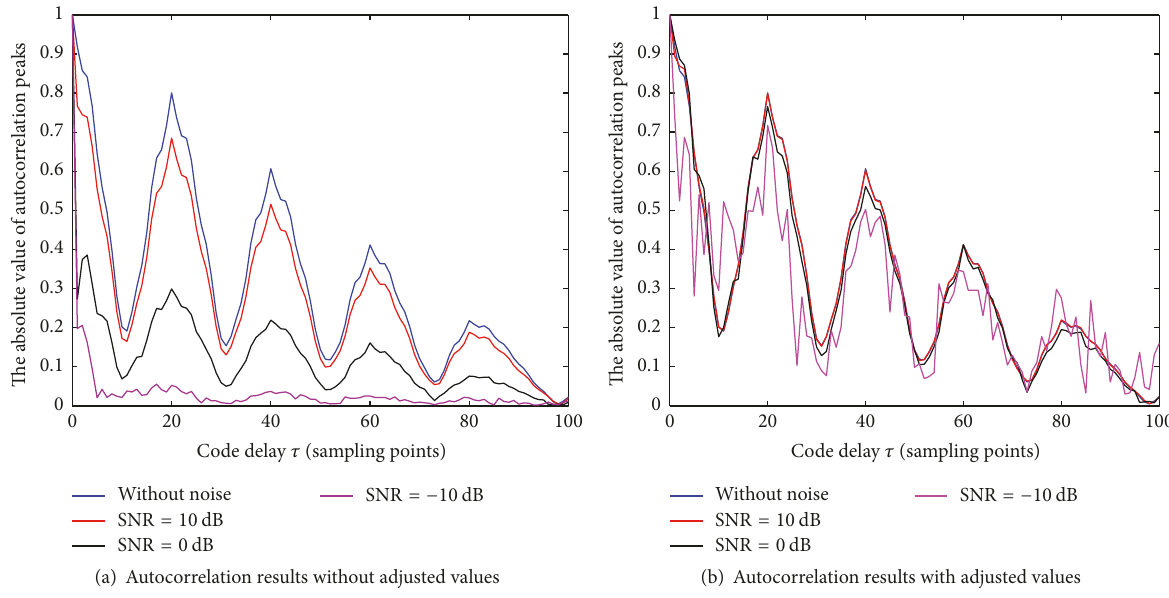
Figure 8: The absolute value of the autocorrelation peaks with different